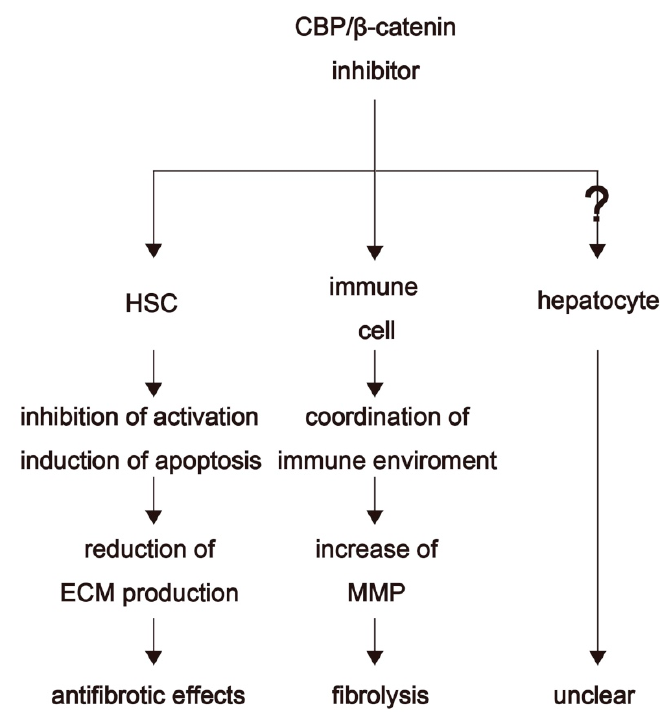
Figure 3. The effects of CBP/ β -catenin inhibitors. CBP/ β -catenin inhibitors exert known effects on HSCs and immune cells, but their precise effects in hepatocytes are still unclear.